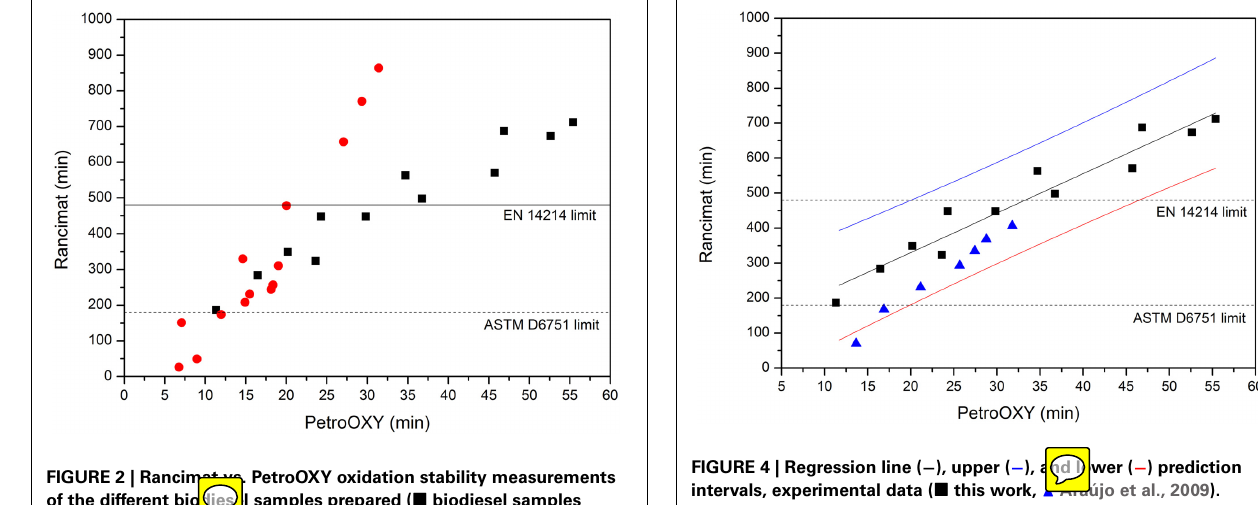
FIGURE 4 | Regression line ( − ), upper ( − ), and lower ( − ) prediction intervals, experimental data ( (cid:2) this work, (cid:3) Araújo et al., 2009). Biodiesel with